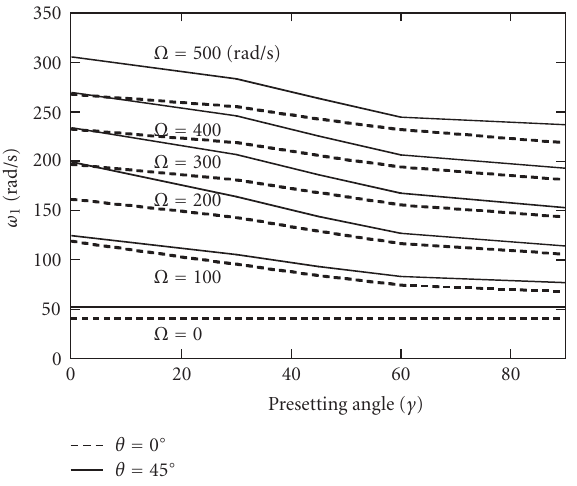
Figure 10: Variation of the first coupled frequency versus preset- ting angle for selected rotational speeds and two di ff erent ply angles ( β 0 = 45 deg).